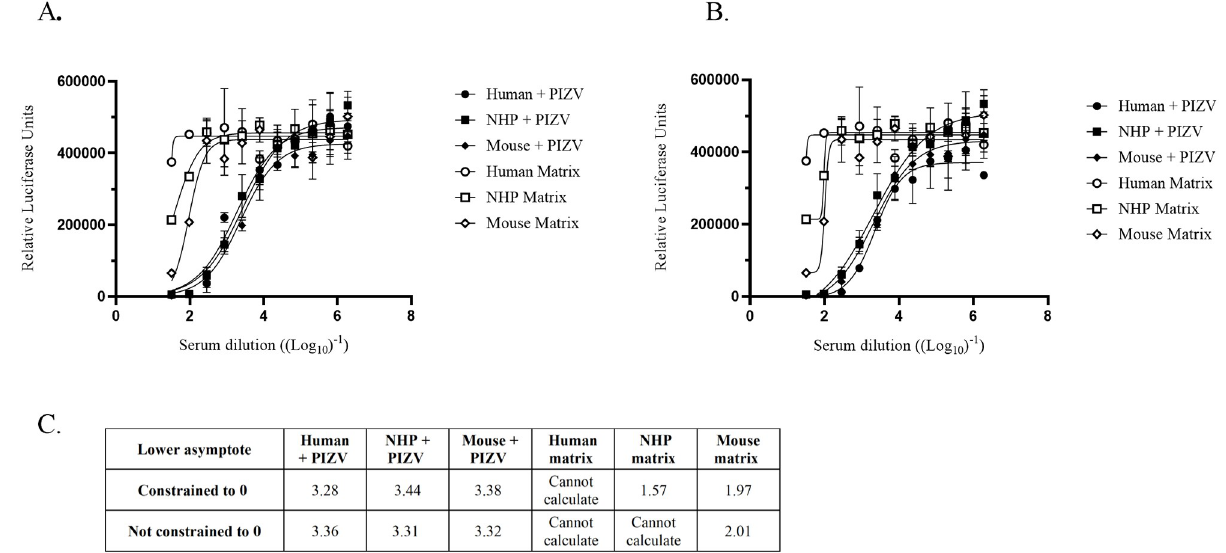
Fig 6. Typical Z-RVP-384 assay neutralization curves of three species using negative and positive sera. Nonlinear regression neutralization curves of human, rhesus macaque, and mouse serum from vaccinated subjects (+ PIZV) or nonvaccinated subjects (Matrix; defined as na ï ve serum of the species). Each serum dilution was measured in duplicate and the lower asymptote of the nonlinear regression curve was constrained to 0 (A) or left unconstrained (B) . Neutralization Titers in log 10 are shown in (C) as calculated by nonlinear regression in GraphPad Prism. Cannot calculate = effect on curve was too low to calculate a